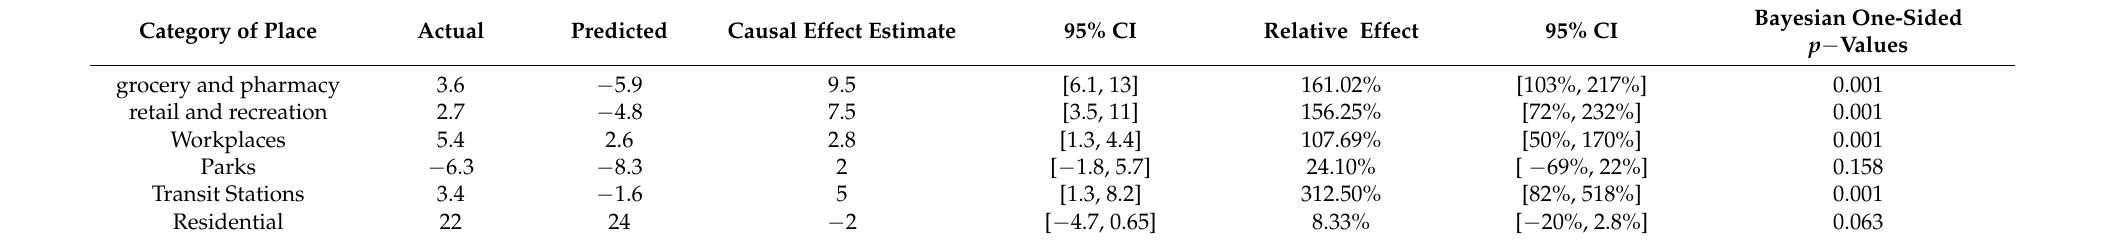
Table 5. Causal effect of lockdown Level 4 implemented 1 May 2020, for each category of places.